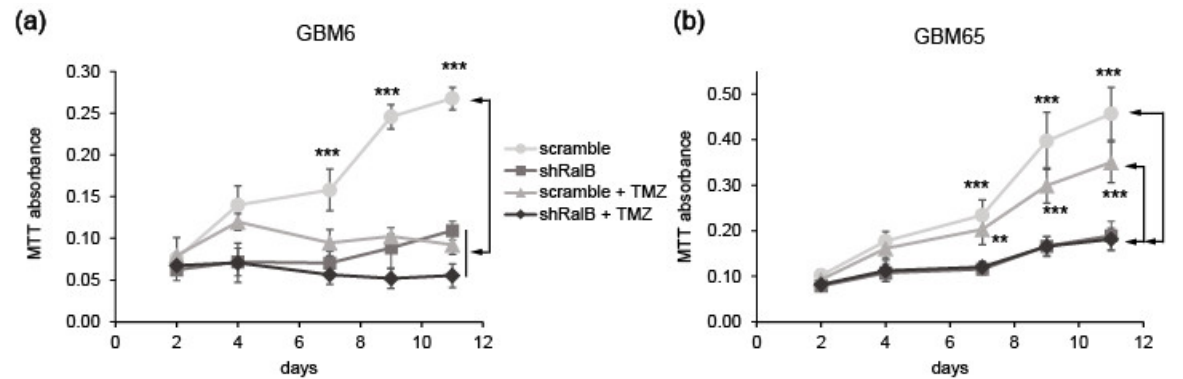
Figure 8. Effects of the treatment of primary glioblastoma cells with temozolomide (TMZ) and RalB downregulation. GBM6 ( a ) or GBM65 ( b ) cells infected with lentivirus driving scramble or shRalB were treated with TMZ (100 μM) or placebo. Growth was analyzed by MTT assay at different time points. Values represent mean ± SEM ( n = 3). Significance was determined by ANOVA and Tukey-HSD post-test. Significance of scramble ± TMZ versus shRalB ± TMZ groups is represented (** p < 0.01; *** p < 0.001).